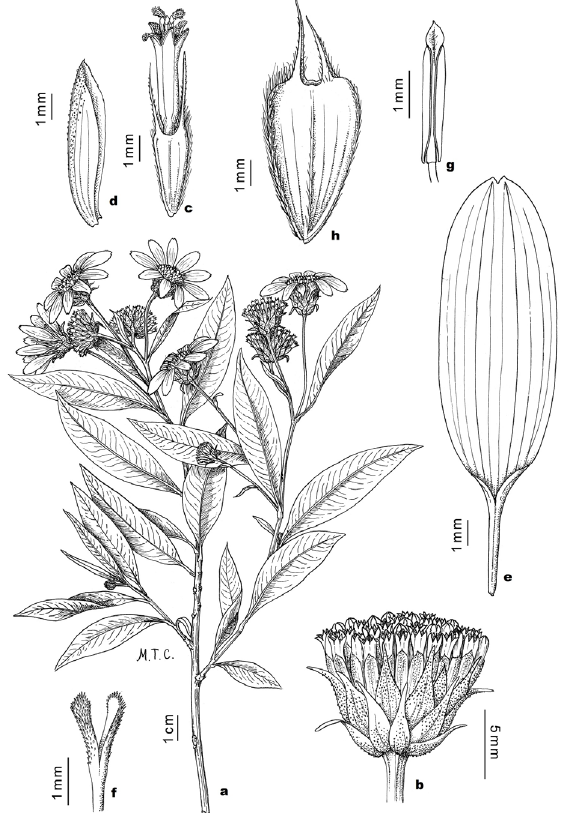
Figure 4. Austroflourensia thurifera [sub F. riparia from Ariza and Ospina in Fl. Argentina 7(2): 210. 2015]. a: Habit; b: Capitulum without ray florets; c: Disc floret; d: Palea; e: Ray floret (neuter); f: Style branches; g: Stamen; h: Disc